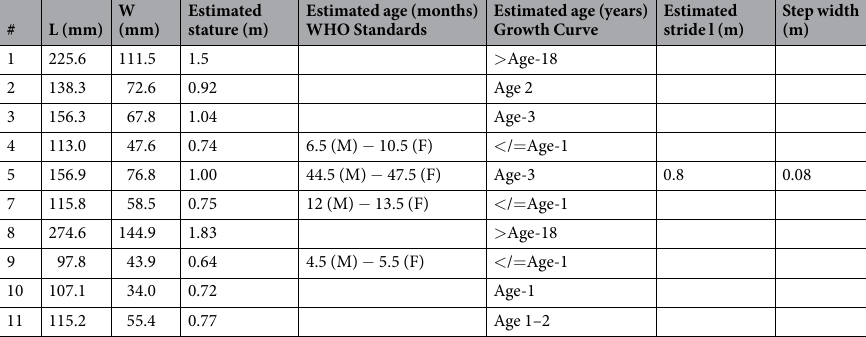
Table 1. Track-maker stature and age estimates for tracks at Melka Kunture, Gombore II-2. Length is the maximum length along the long axis of the track, while width is the maximum width perpendicular to this axis. Stature is based on approximate relationship of foot length to stature of 15%. In the case of P-03 and P-05 it is possible to tentatively suggest that they may have been made by the same individual, hence the step width and stride length estimates. Track P-06 is not included here because it is incomplete and the product, we suggest, of multiple foot